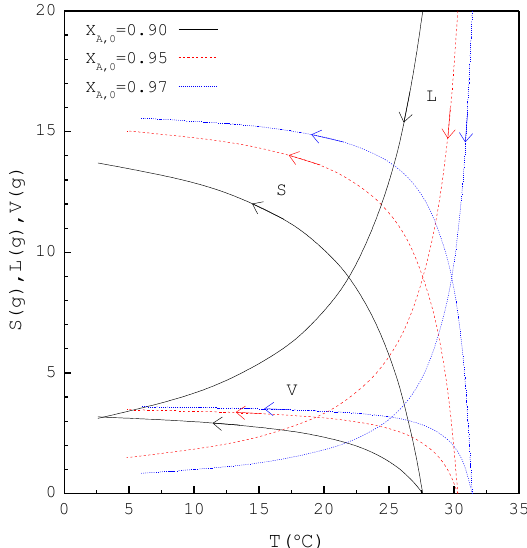
Figure 10. The calculated results of S(T), L(T), and V(T) during the SC cooling process for the purification of m-chlorophenol.